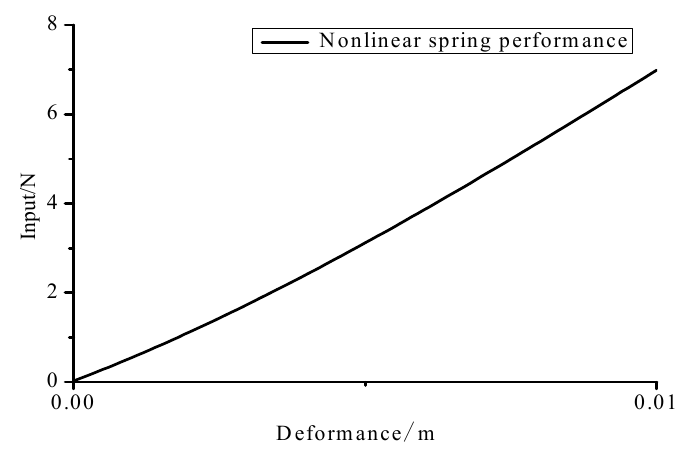
Figure 12. Beam model and FBG sensing network. Materials 2017 , 10 , 1162